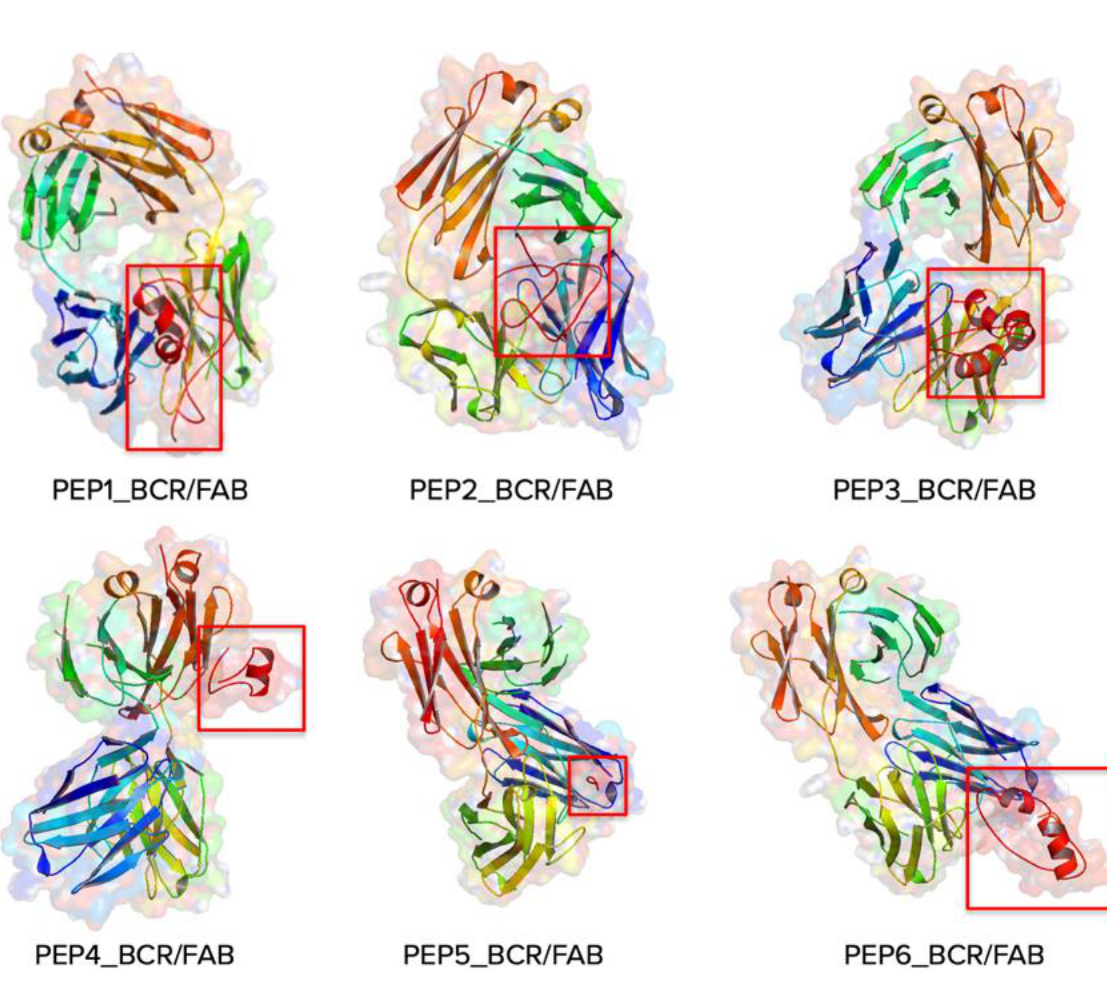
Figure 4. Visualization results from the molecular docking process between each of the peptides with BCR/FAB receptor in 3D structure visualization. It shows that each peptide binds perfectly with the BCR/FAB fragment